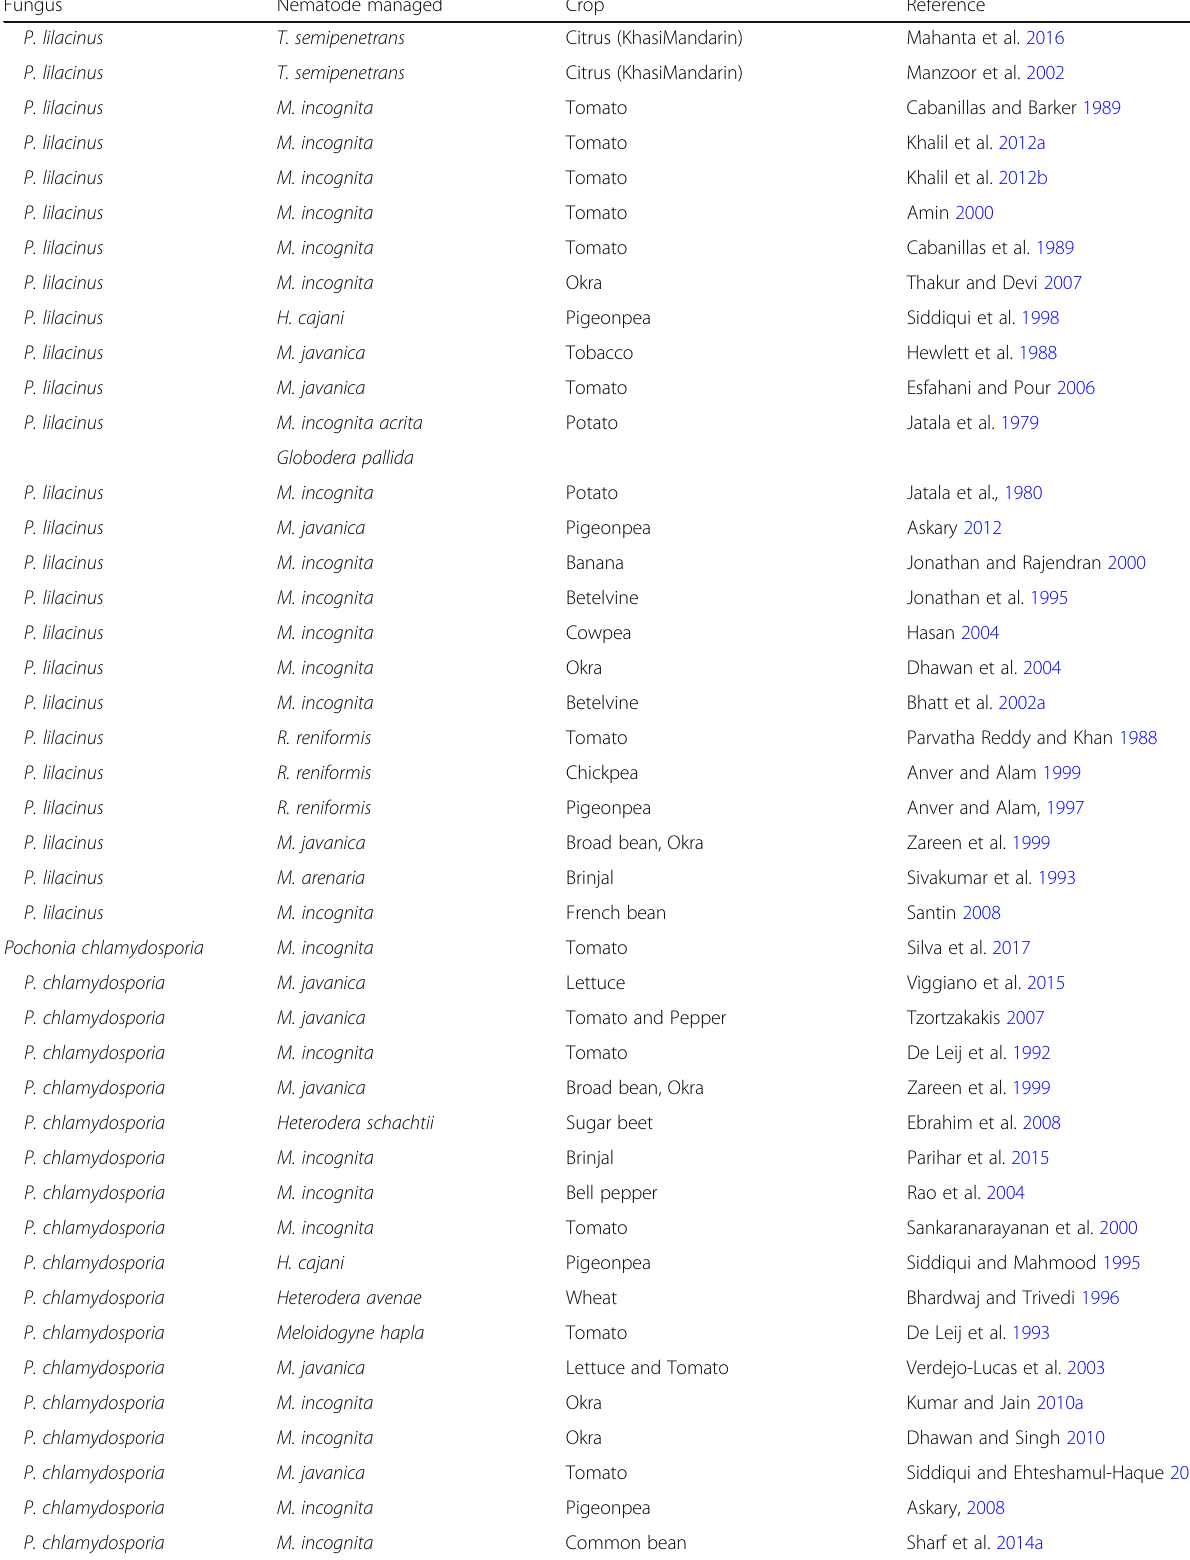
Table 4 Biocontrol agents of fungal species targeting nematodes on economic crops (Continued)